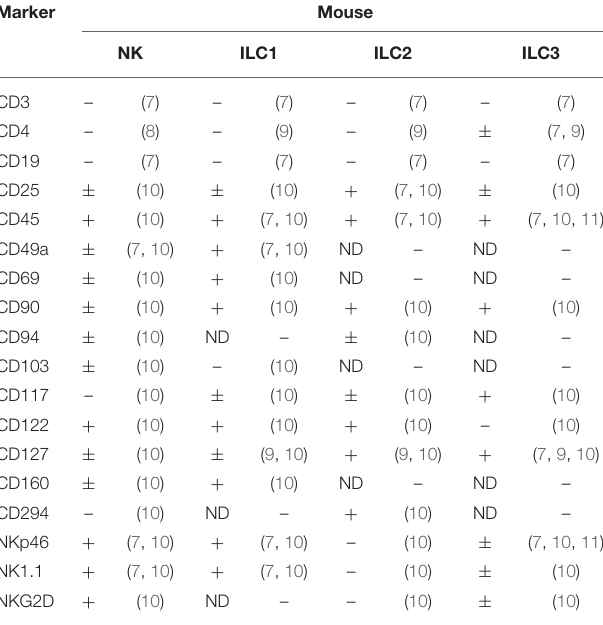
TABLE 1 | Phenotype of murine ILCs.